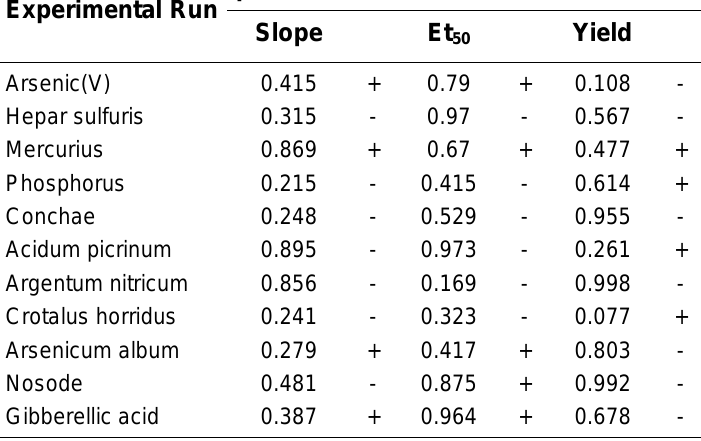
Statistical Analysis of the Screening Experiments